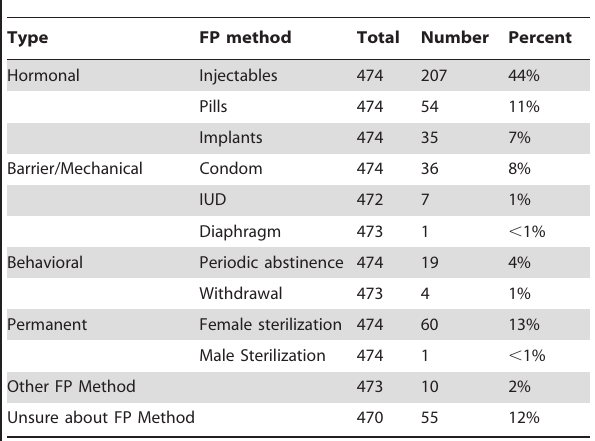
Table 4. Preferred Family Planning Method.* Table 5. Reasons Given by Women Who Had Never Used a